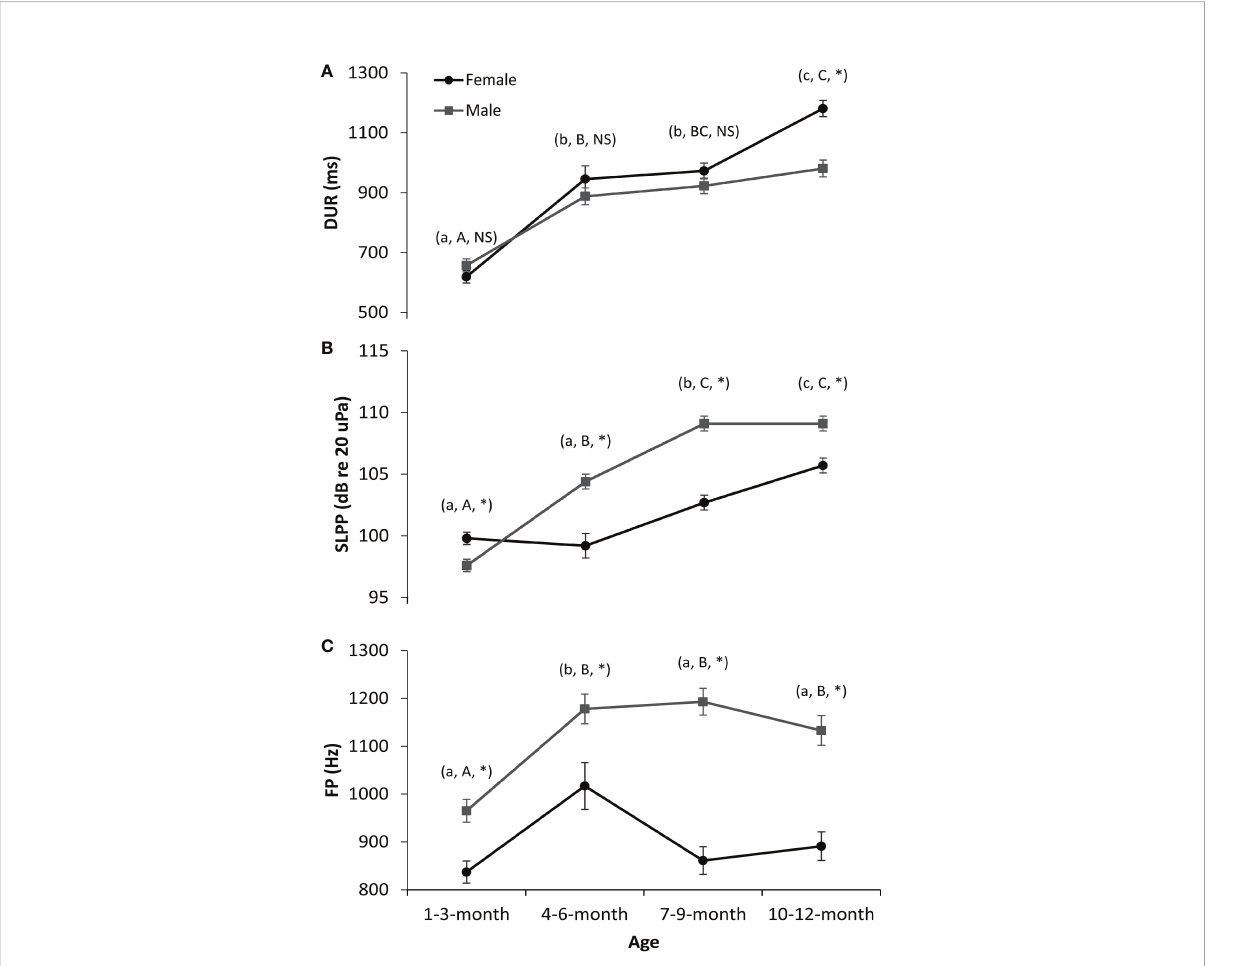
FIGURE 2 Interaction effects on the sound parameters of spotted seal pups. (A) Duration (DUR). (B) Peak frequency (FP). (C) Peak-to-peak source level (SLPP). The dark lines and circles represent the results for females, while the gray lines and squares represent the results for males. Lowercase letters in the parentheses indicate the comparison results of each sound parameter of female seals among four age groups (i.e., 1 – 3, 4 – 6, 7 – 9, and 10 – 12 months old). Groups with different lowercase letters indicate a signi fi cant statistical difference between them, while those with the same letter indicate no statistical difference. Similarly, uppercase letters in the parentheses indicate the comparison results for male seals. NS denotes no signi fi cance between sexes in that age group, while * denotes signi fi cance. A p -value < 0.05 is considered statistically signi fi